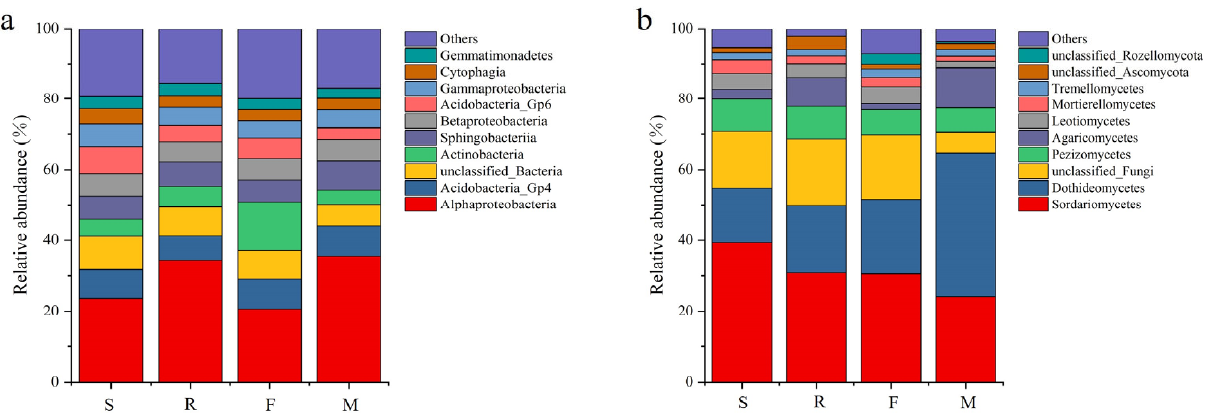
Figure 2. The relative abundance of bacterial ( a ) and fungal ( b ) community composition at the class level. S, R, F, and M represent the seedling stage, rapid growth stage, flowering stage, and maturity stage, respectively.